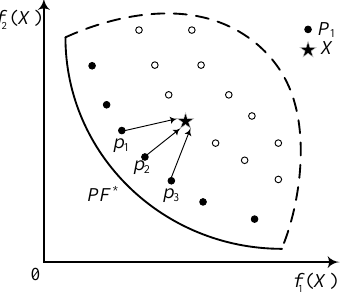
Figure 6. The rotating targets of quantum rotation.